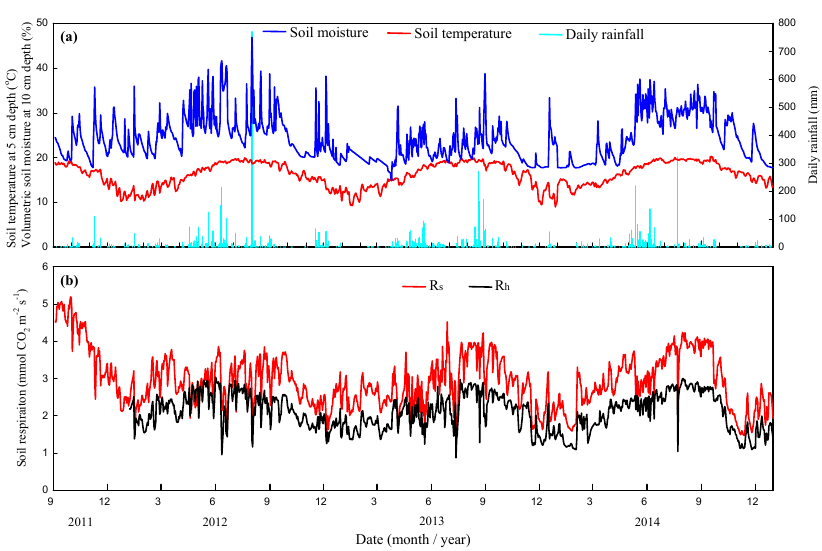
Figure 2. Time series for ( a ) environmental data (e.g., soil temperature, soil moisture, and total daily rainfall) and ( b ) soil respiration data (e.g., Rs and Rh).